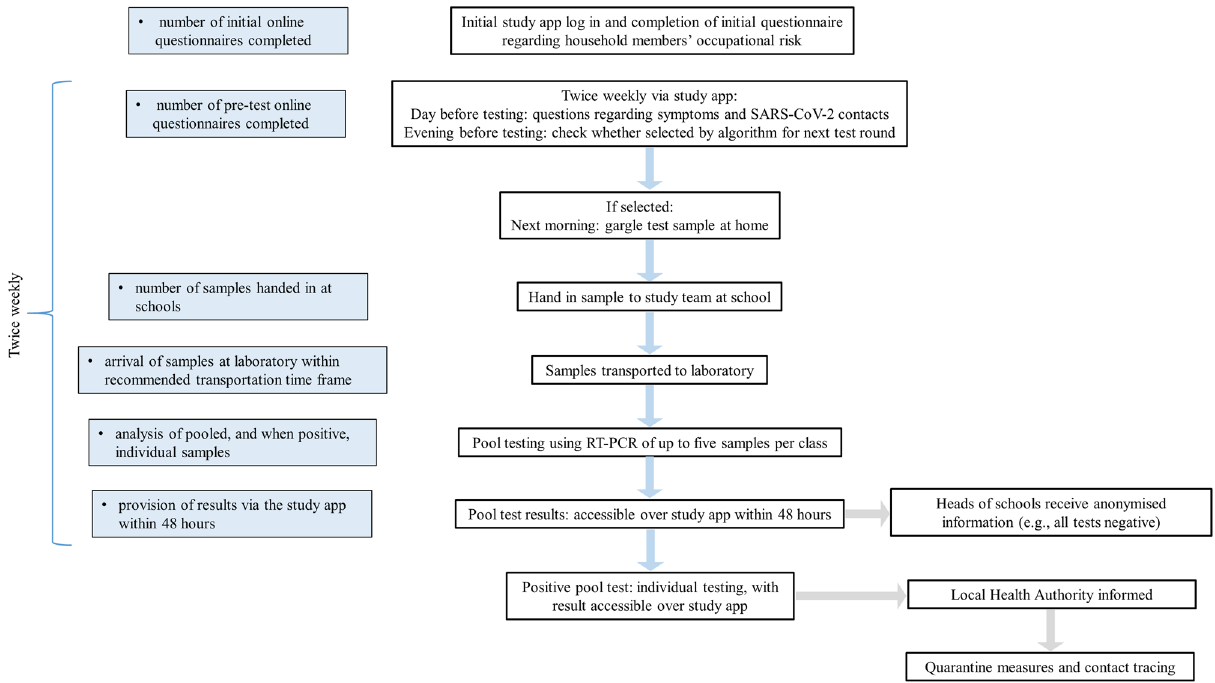
Figure 2. Surveillance programme overview. The light blue boxes indicate the formally evaluated logistical steps for determining programme